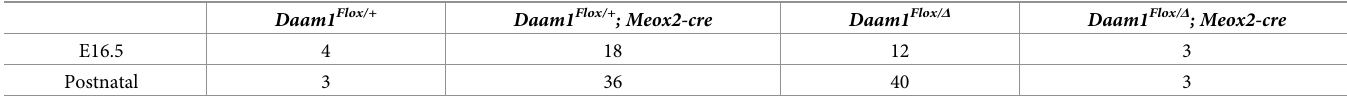
Table 2. Number of embryos or mice from crosses between Daam1 flox/flox and Daam1 Δ /+ ; Meox2-cre